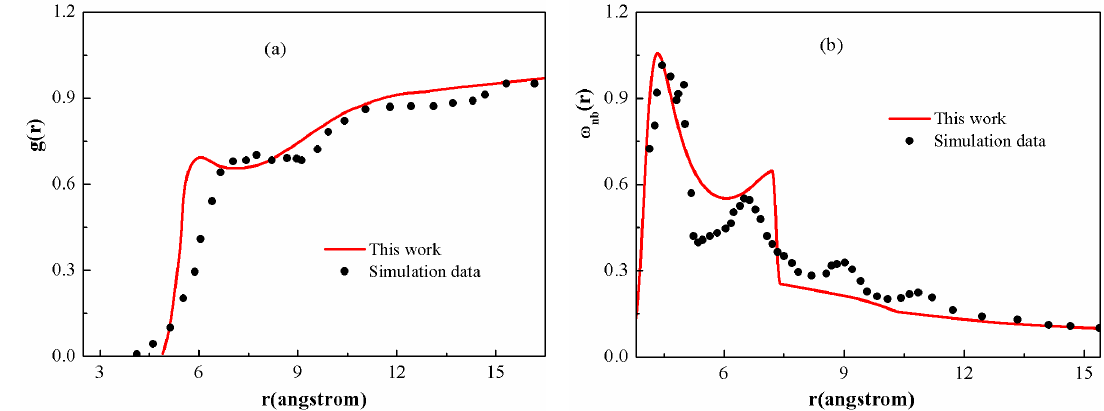
Figure 2. Comparison of the average ( a ) inter- and ( b ) intramolecular correlation functions of the PS chain obtained from theory and molecular simulations [42] at 413.2 K.